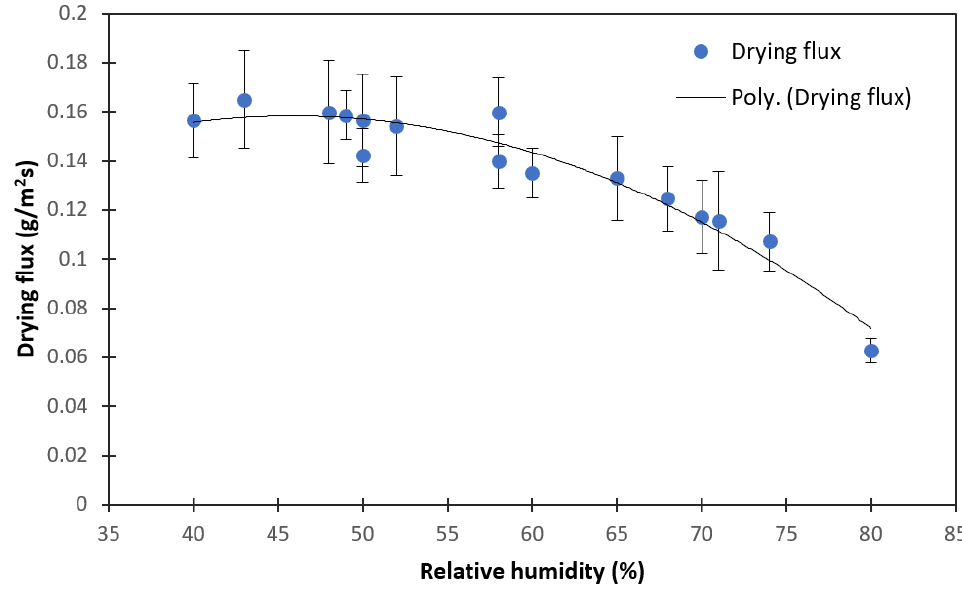
Figure 5. Changes in drying flux with relative humidity.